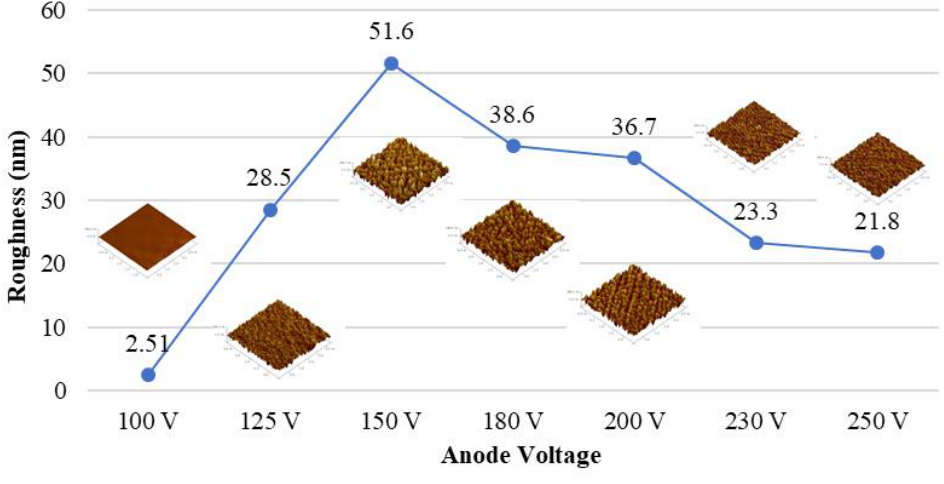
Figure 2. Roughness of PC substrates after different ion bombarding voltages.